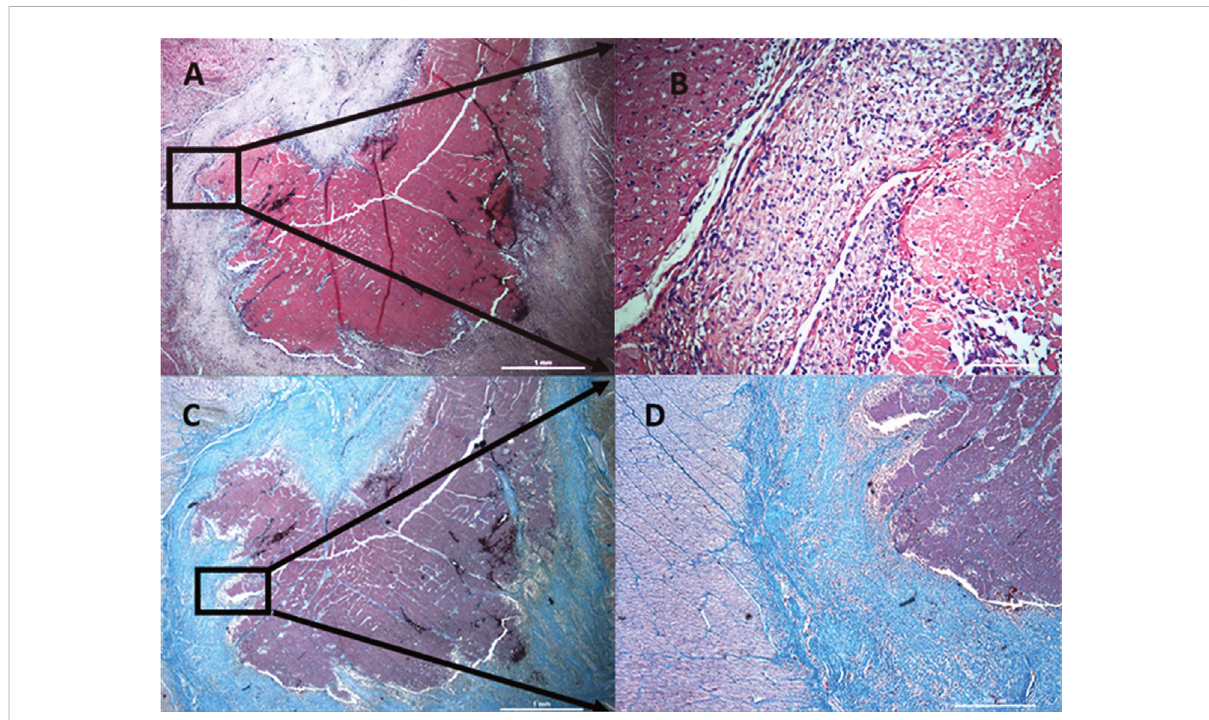
FIGURE 6 Histological characteristics of lesions created after radiofrequency ablation of porcine hearts. Lesions created by radiofrequency ablation are formedbycoagulationnecrosis,wherecellshavenobordersandtheyarecompletelydestroyed.Nucleiarenotvisible.Everylesionissurroundedby a differently wide rim consisting of cells at different stages of necrosis (damaged cell membrane and nuclei) sharply transitioning into healthy cardiomyocytes (clearly demarcated individual cells, pink cytoplasm, distinct purple nuclei). (A) hematoxylin-eosin staining, magni fi cation 25x. (B) detail from A , magni fi cation 200x, (C) trichrome staining, magni fi cation 25x, (D) detail from C, magni fi cation 50x.